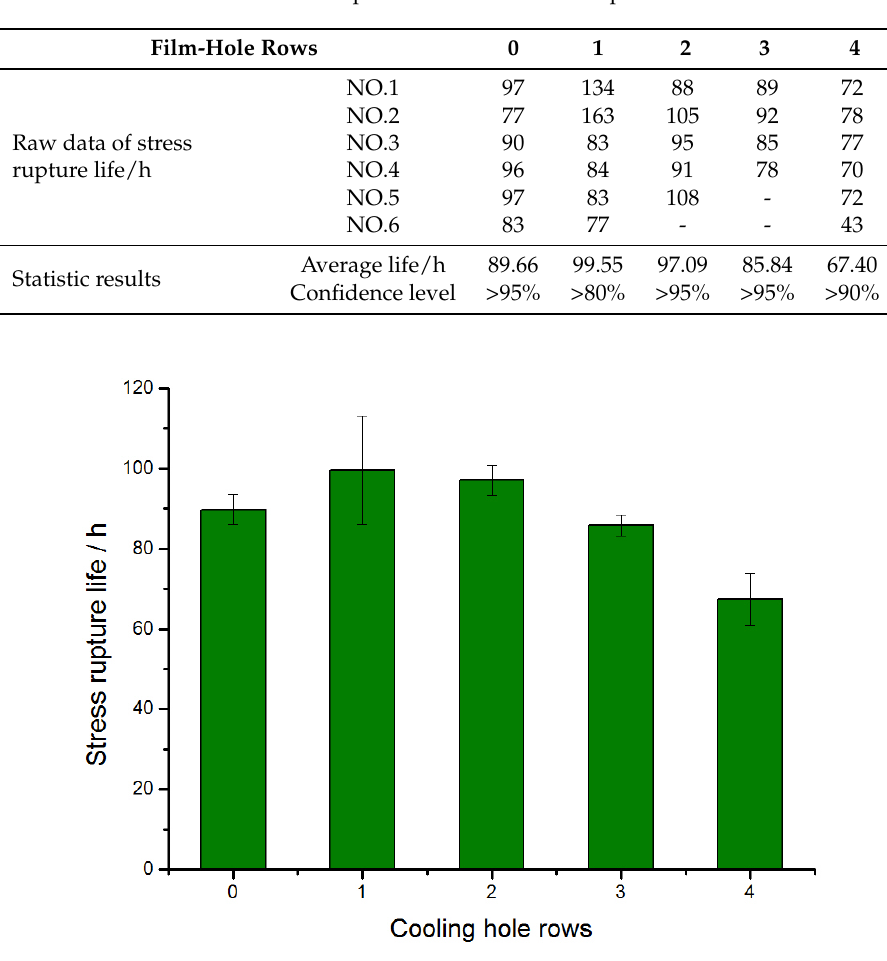
Figure 5. Film-hole configuration dependence of the creep rupture